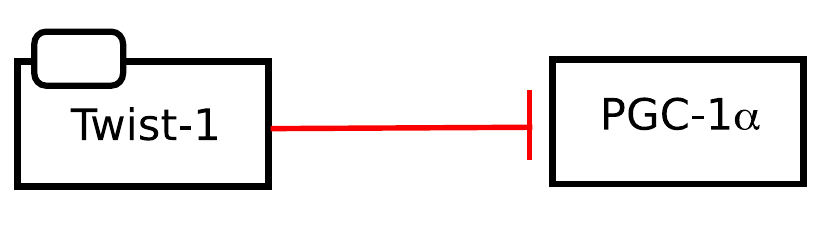
Figure 2.17: The Activity Flow glyph for negative influence .